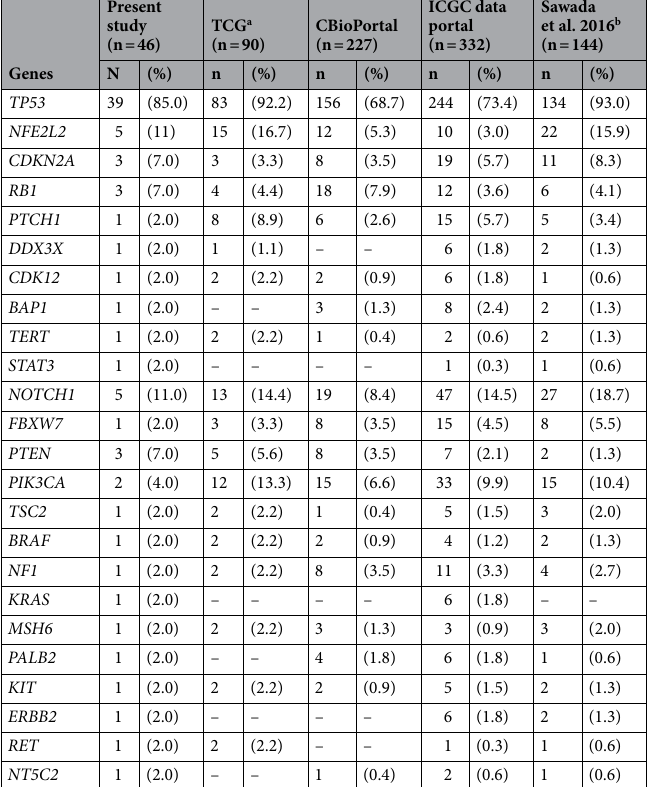
Table 6. Comparison of mutation frequencies in esophageal squamous cell carcinoma patients. cBioPortal for Cancer Genomics http:// cbiop ortal. org; ICGC International Cancer Genome Consortium https:// dcc.